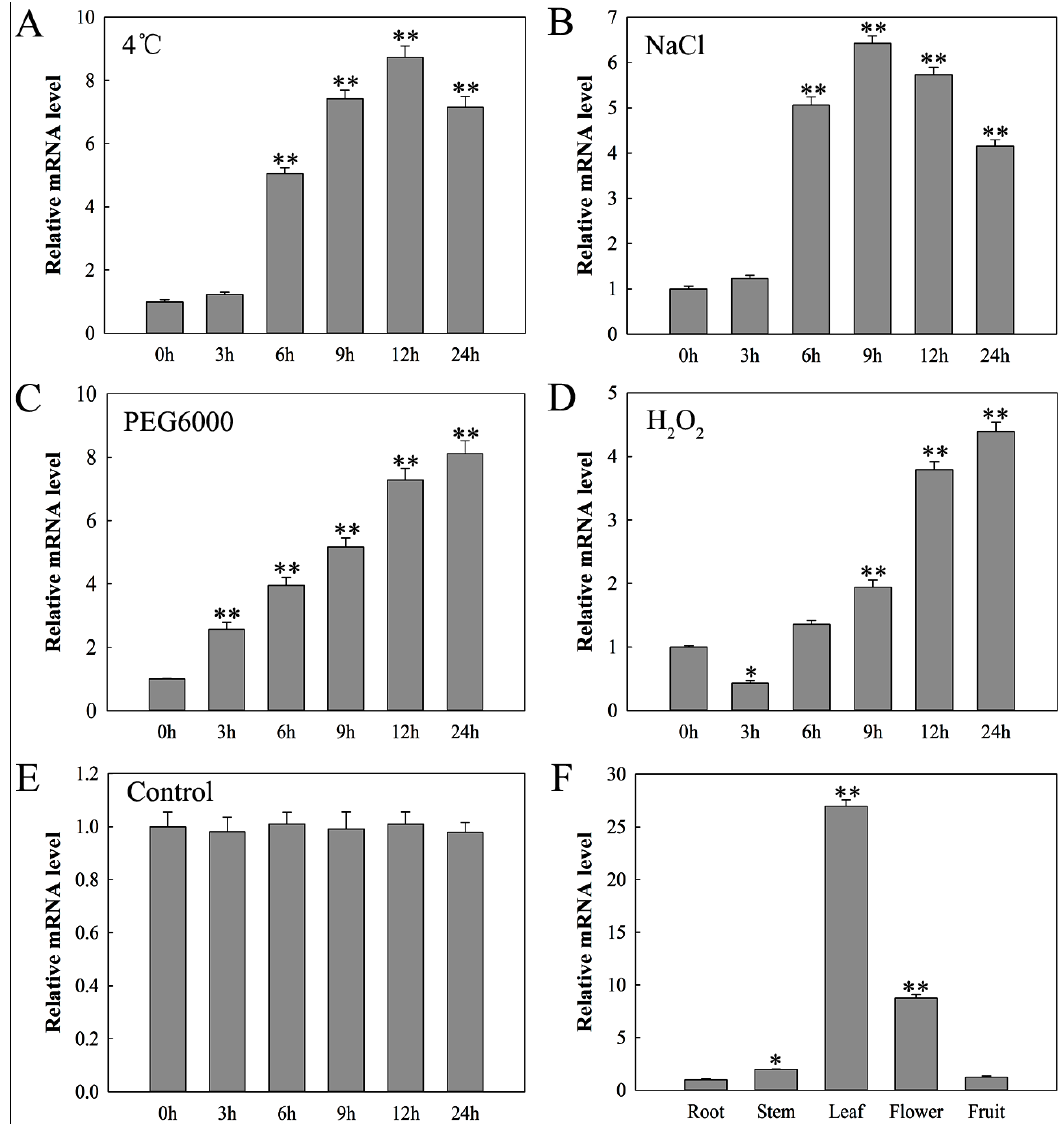
Figure 4. Quantitative PCR analysis of the expression profiles of SlDnaJ20 in tomato: ( A ) 4 °C, ( B ) 250 mM NaCl, ( C ) 20% polyethylene glycol (PEG), ( D ) 10 mM H 2 O 2 , ( E ) control, ( F ) expression of SlDnaJ20 in different tomato tissues. The mean values ± SD of at least three replicates are presented, and * p < 0.05 and ** p < 0.01 indicate significant differences compared with the control.